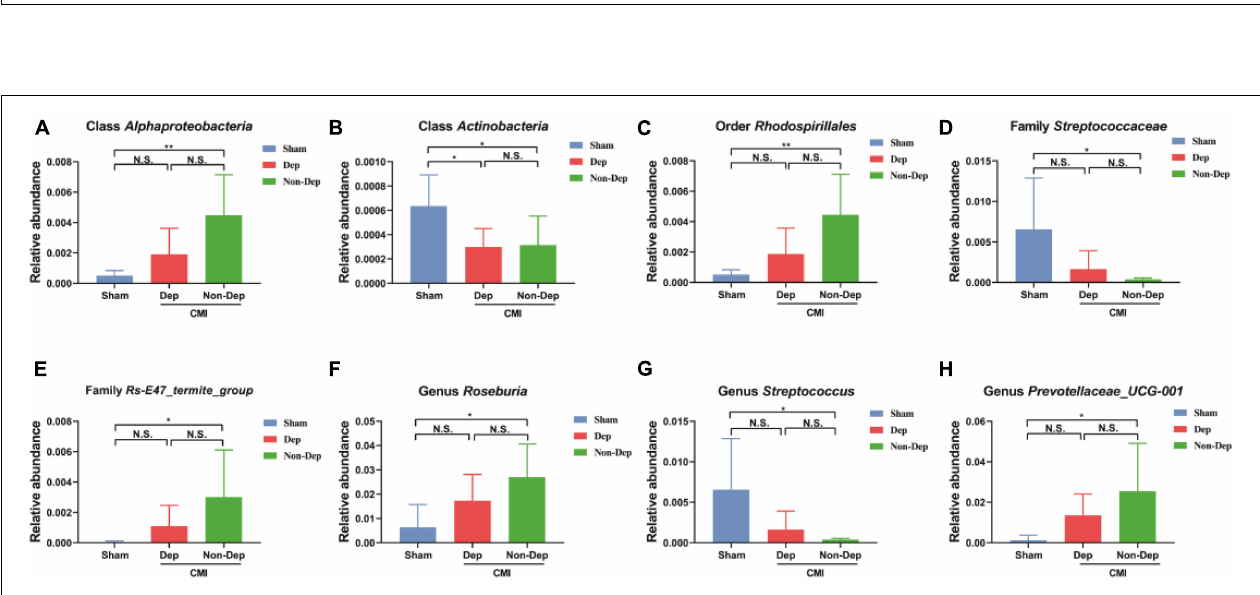
FIGURE 5 | Differences in the relative abundance of various gut microbes among the Sham group, the CMI + Dep group, and the CMI + Non-Dep group. (A) Class Alphaproteobacteria (F2, 16 = 7.358, p < 0.05). (B) Class Actinobacteria (F2, 16 = 4.512, p < 0.05). (C) Order Rhodospirillales (F2, 16 = 7.270, p < 0.05). (D) Family Streptococcaceae (F2, 16 = 4.685, p < 0.05). (E) Family Rs-E47_termite_group (F2, 16 = 3.540, p < 0.05). (F) Genus Roseburia (F2, 16 = 5.120, p < 0.05). (G) Genus Streptococcus (F2, 16 = 4.685, p < 0.05). (H) Genus Prevotellaceae _UCG-001 (F2, 16 = 3.831, p < 0.05). Data are shown as mean ± SEM. ( n = 6–7) by one-way ANOVA. CMI, chronic myocardial infarction; Dep, depression-like behavior; Non-Dep, non-depression-like behavior. * p < 0.05, ** p < 0.01, N.S., not significant.